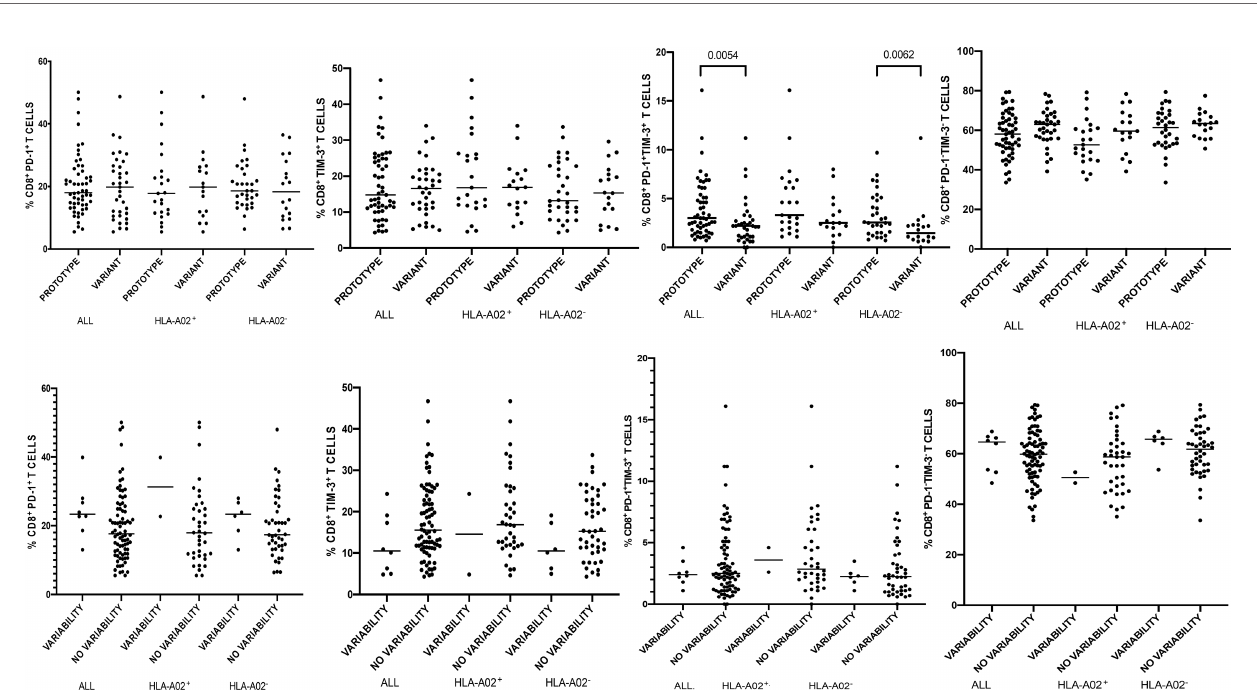
FIGURE 2 | Percentages of peripheral blood CD8 + T-cells expressing PD-1/Tim-3 in patients infected with either NS3 1073 prototype (GenBank EU255962.1) or variant epitope sequence as the dominant strain (upper panel). Lower panel shows intrahost aminoacid variability of this epitope where no variability denotes the presence of a single variant and variability indicates ≥ 2 variant sequences. Horizontal lines represent median values. Numbers above each bracket express P